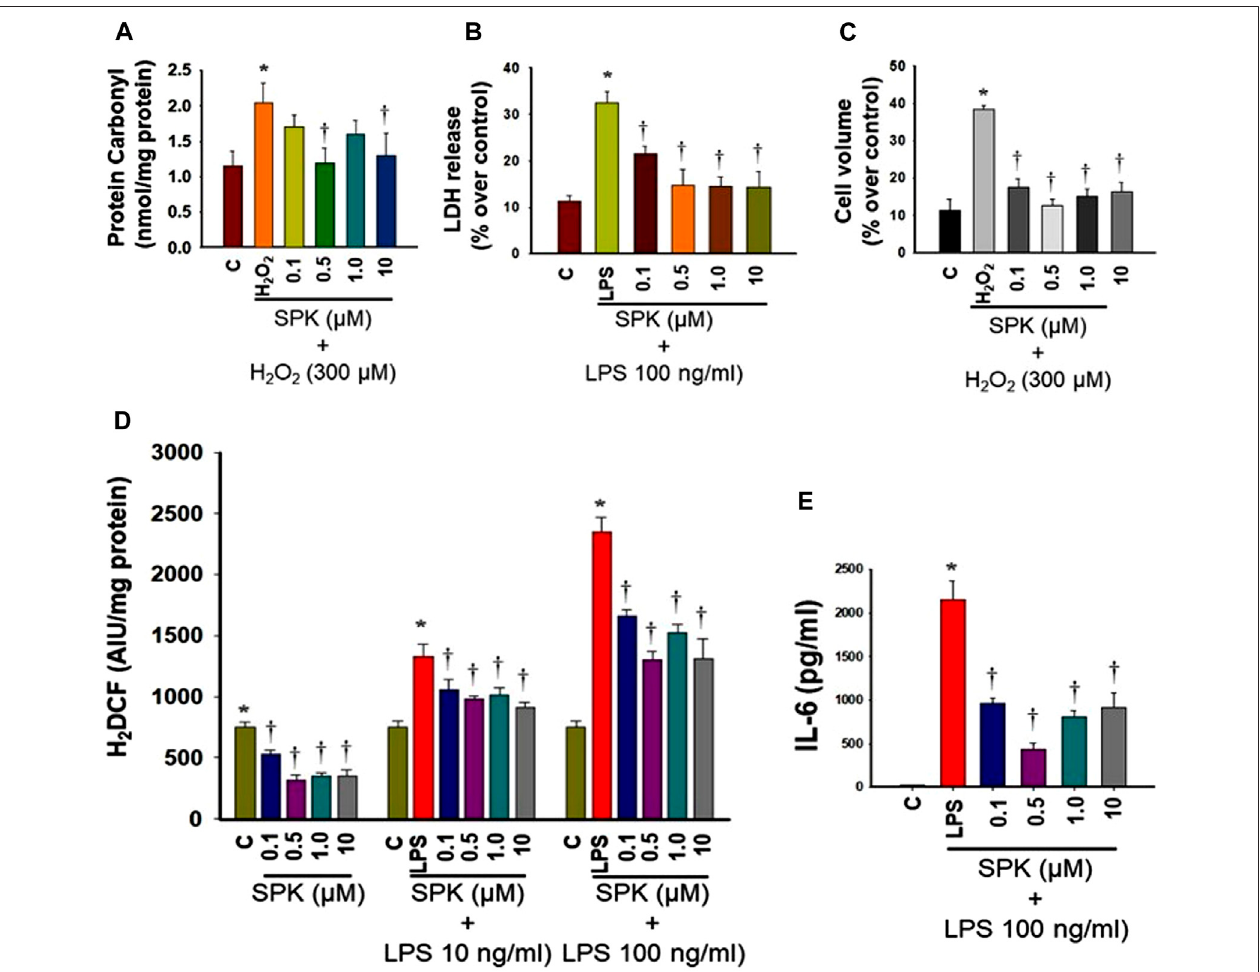
FIGURE 12 | Effect of SPIKENET (SPK) on hydrogen peroxide (H 2 O 2 )-induced oxidative stress (protein carbonyl formation) (12 h) (A) , and LPS-induced LDH release (36 h) (B) in primary cultures of rat brain microglia, as well as H 2 O 2 -induced increase in cell volume (24 h) in primary cultures of rat brain astrocytes (C) . SPK signi fi cantly diminished these effects in glial cells (30 min post-treatment). Exposure of primary microglia to LPS (24 h) showed an increase in DCF fl uorescence (D) , as well as an increase in IL-6 level (E) in cell culture medium, and such increase was diminished and blocked by treatment of cells (30 min post-treatment) with SPIKENET. C, control; LPS, lipopolysaccharide. * p < 0.05 vs. control. † p < 0.05 vs. LPS. C, control; AIU, arbitrary intensity units; LPS, lipopolysaccharide. Error bars represent mean ±